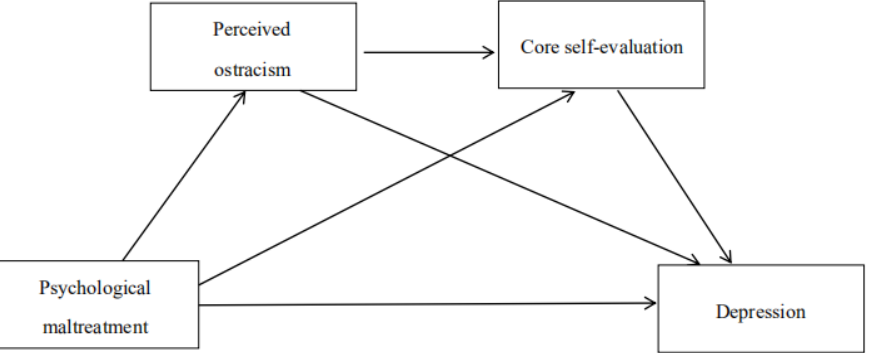
and Figure 1. A multiple mediation model of the association between psychological maltreatment and depression.